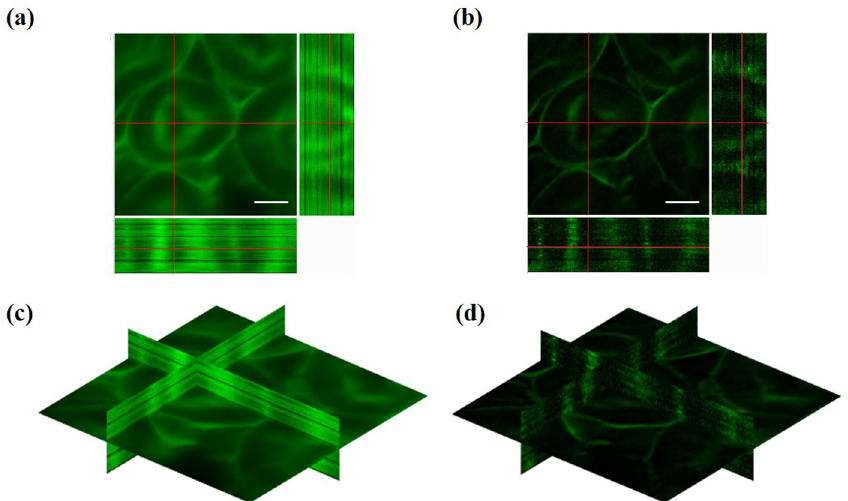
Fig 5. Reconstructed Cross-sectional views of the mouse kidney sample. Cross-sectional views in the x-y, x-z and y- z planes based on (a) uniform illumination and (b) HiLo algorithm; isometric cross-sectional views based on (c) uniform illumination and (d) HiLo algorithm. Scale bar = 15 μ m.